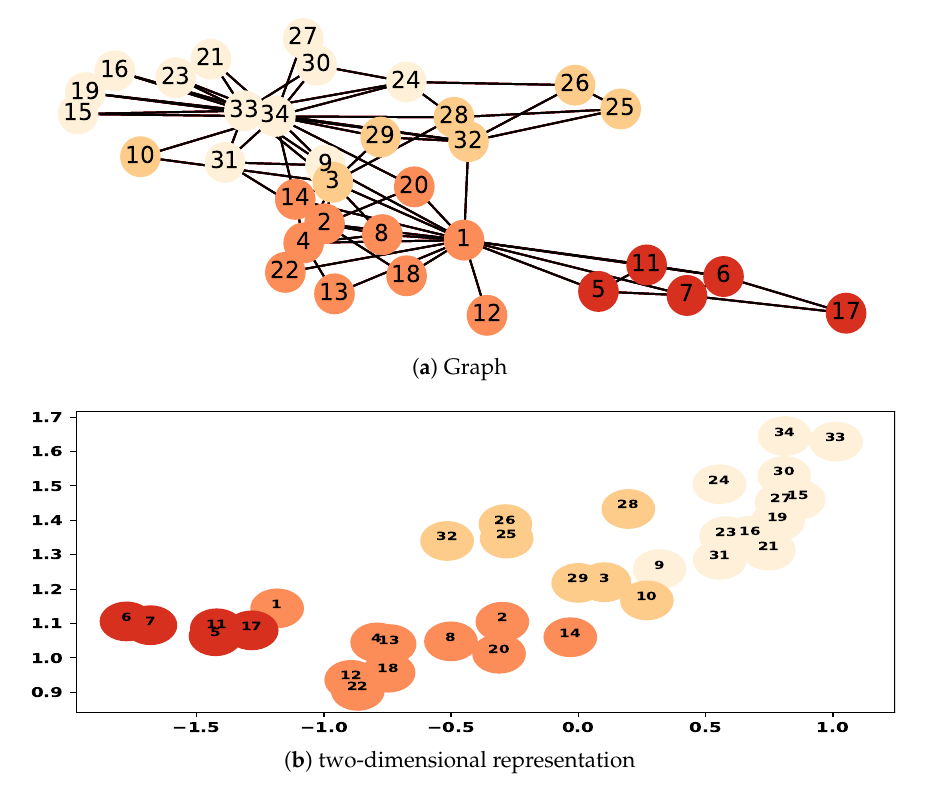
Figure 2. Zachary’s Karate graph and its two-dimensional